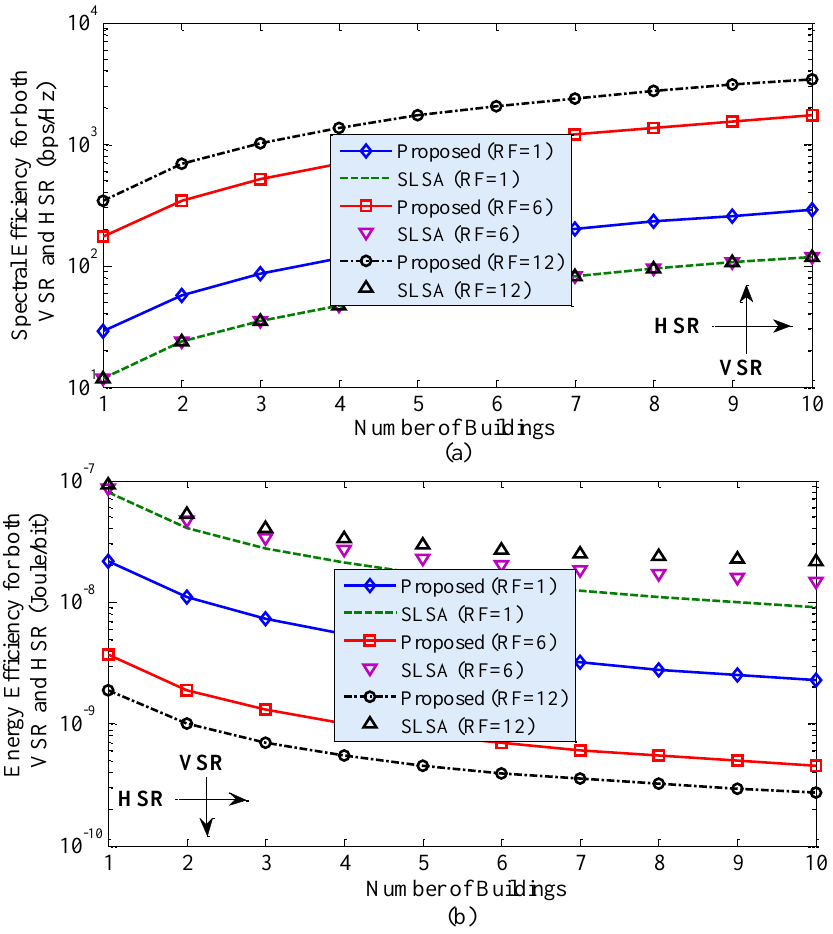
Figure 5. Performance of the proposed technique and the traditional SLSA technique due to the variation in both vertical spatial reuse (VSR) within a building, as well as HSR between adjacent buildings, of small cells in terms of ( a ) SE and ( b ) EE.